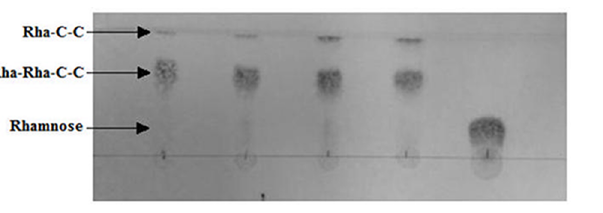
Fig 4. Thin-layer chromatography. In order to analyzethe mono-dirhamnolipidratio, a TLC was carried out by the applicationof 2 μ Lof the final medium supernatant. From left to right: P . aeruginosa PAO1, C/N ratio = 17.5; P . aeruginosa PAO1, C/N ratio = 83.2; P . aeruginosa -estA, C/N ratio = 17.5; P . aeruginosa -estA, C/N ratio = 83.2; and a 5g/mL rhamnose standardsolution.